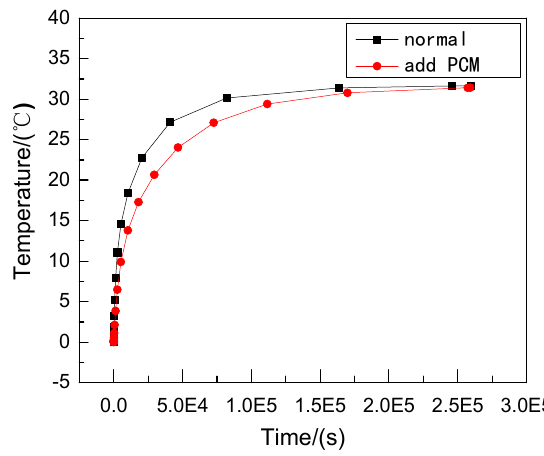
Figure 8. Steady-state heat transfer temperature characteristic curve (containing decanoic acid).